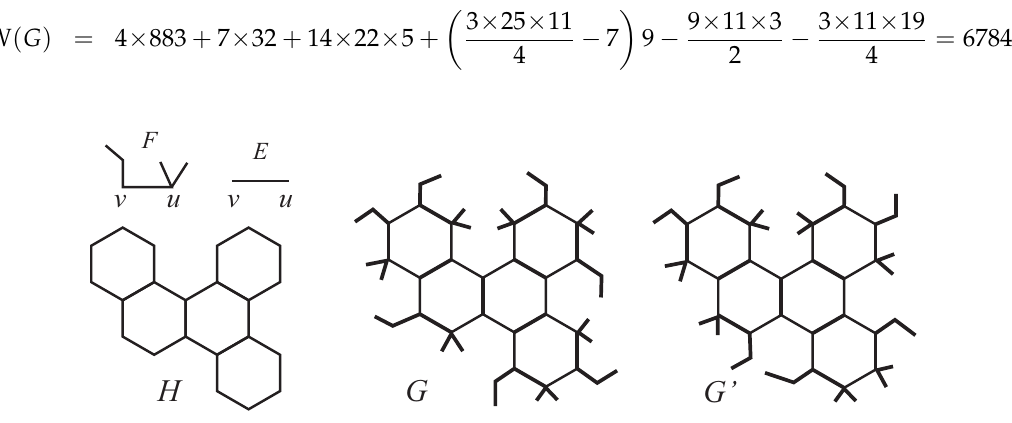
Figure 6. Attaching graphs F and E to benzenoid graph H